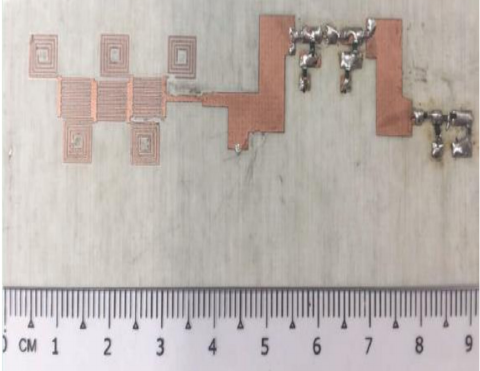
Figure 8. Fabricated prototype of the suggested rectenna [184].